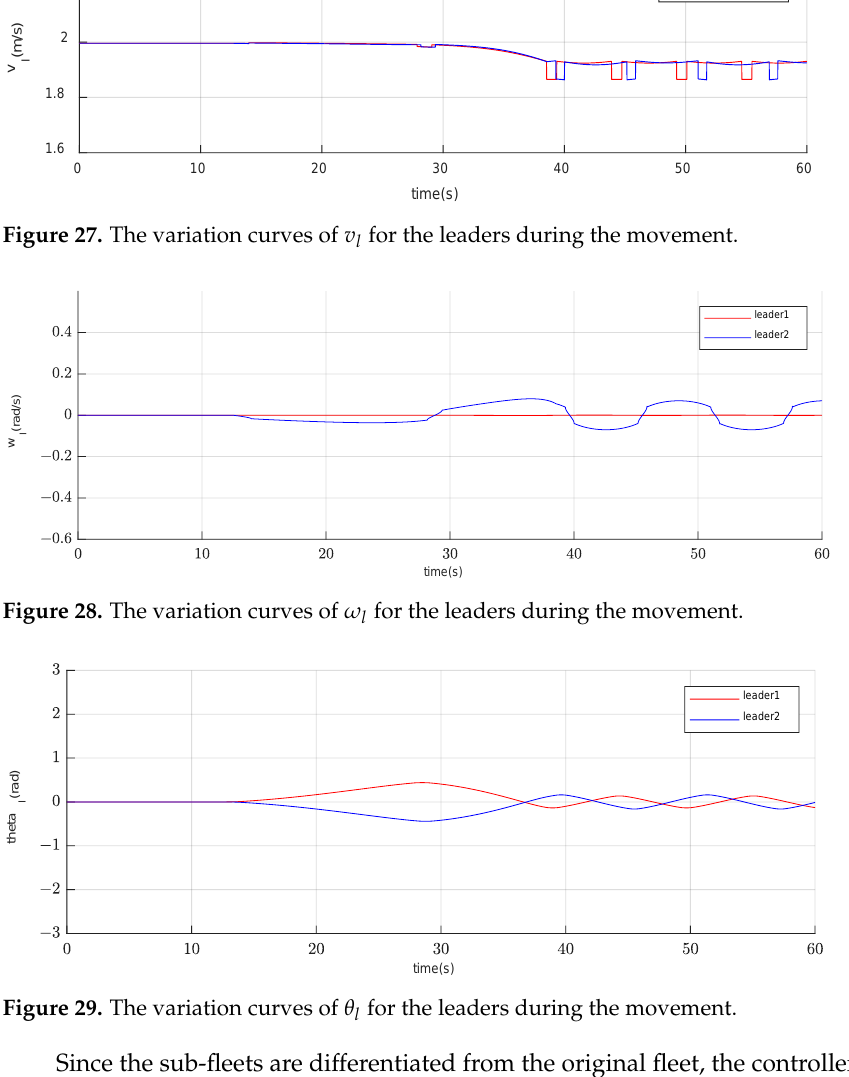
Figure 29. The variation curves of